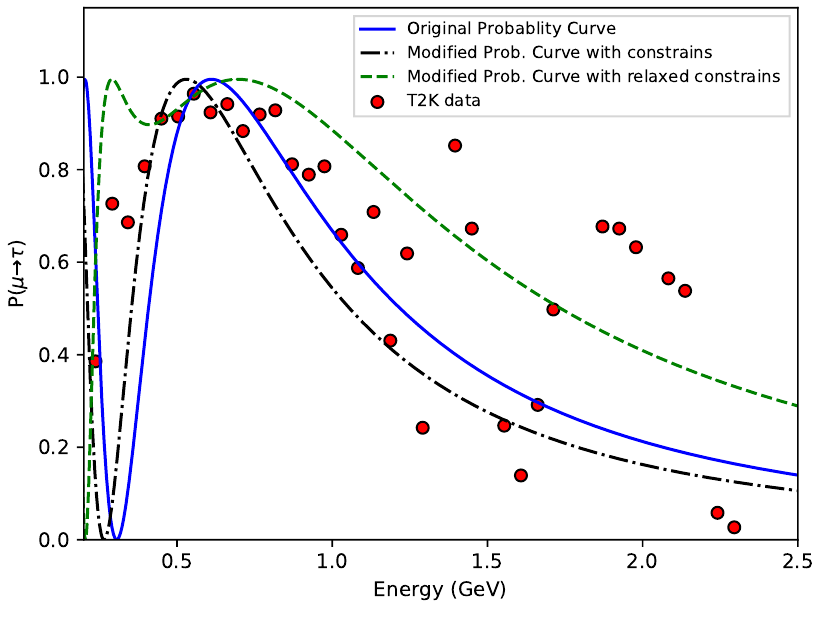
Figure 1. For L 1 , we have the transition probability of ν µ neutrino in the graph below. For the con- = 0 . 0022 [eV 2 ]. The modified probability equation strained case, we have A = 999 [1 / GeV] & ∆ m 2 32 with constrains has a smaller χ 2 value of 26.10 as compared to the original probability curve’s 33.75. = 0 . 0041 [eV 2 ]. The modified For the relaxed constrain case, we have A = 0 . 04 [1 / GeV] & ∆ m 2 32 probability equation with relaxed constrains has a smaller χ 2 value of 6.41 as compared to the original probability curve. The modified probability curve with relaxed constraints gives the best fit.